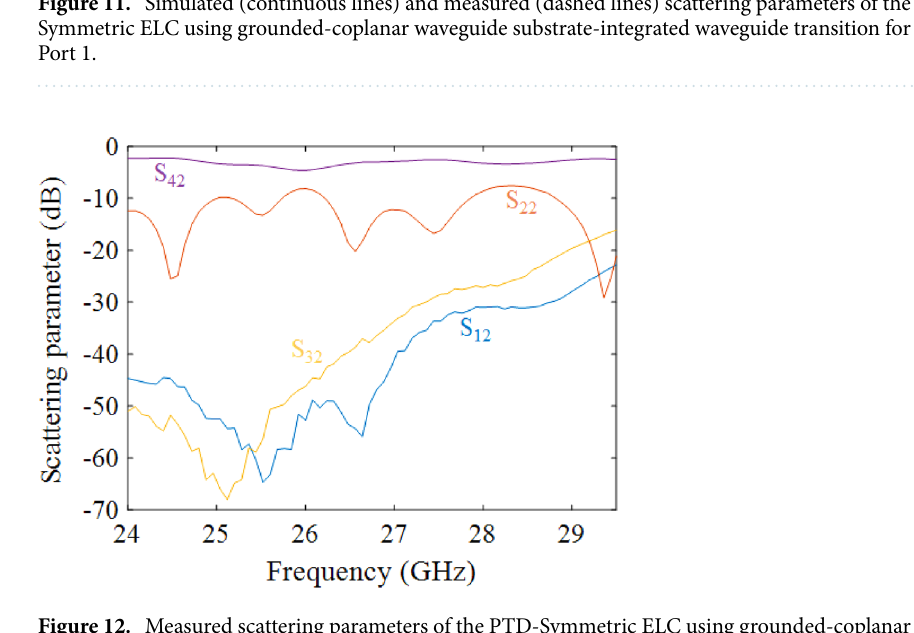
Figure 12. Measured scattering parameters of the PTD-Symmetric ELC using grounded-coplanar waveguide substrate-integrated waveguide transition for excitation at Port